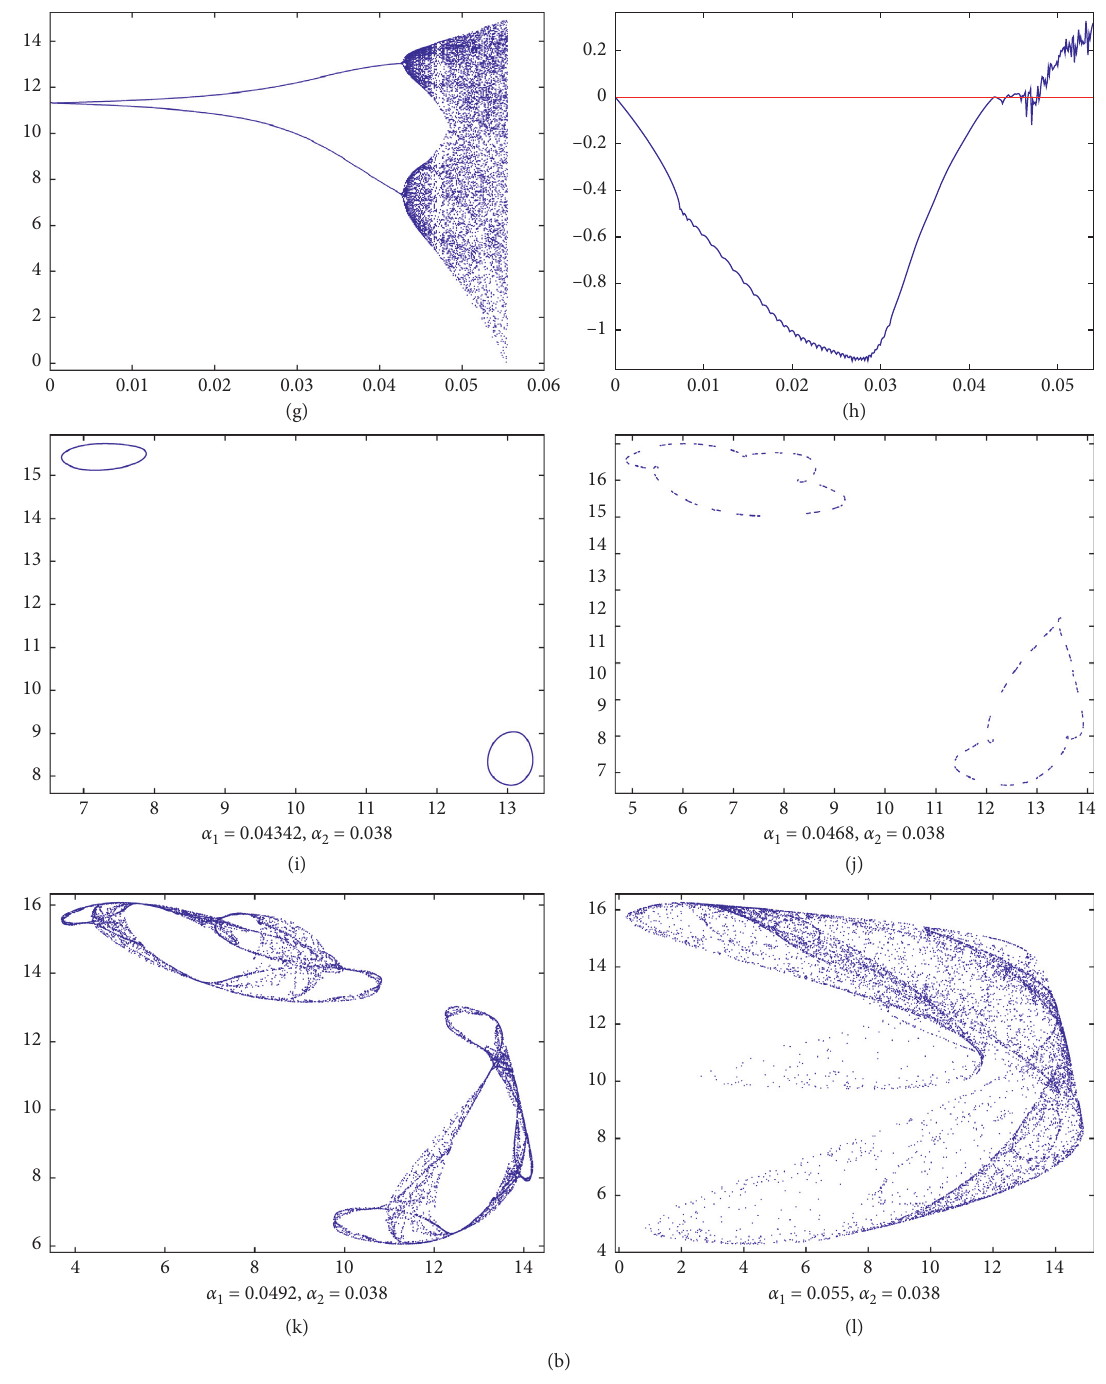
Figure 4: Bifurcation diagrams and chaos